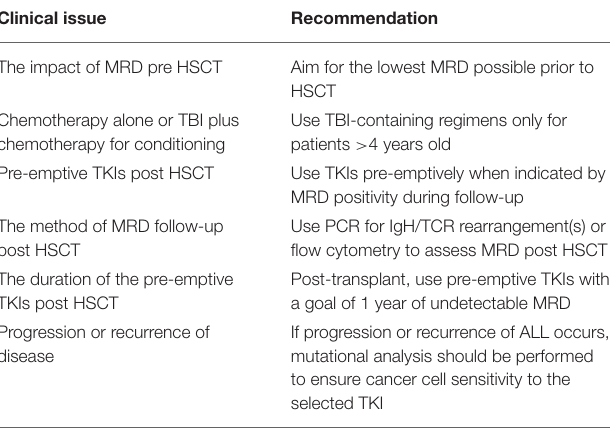
TABLE 2 | Key recommendations for the use of HSCT in paediatric Ph + and Ph-like ALL. Clinical